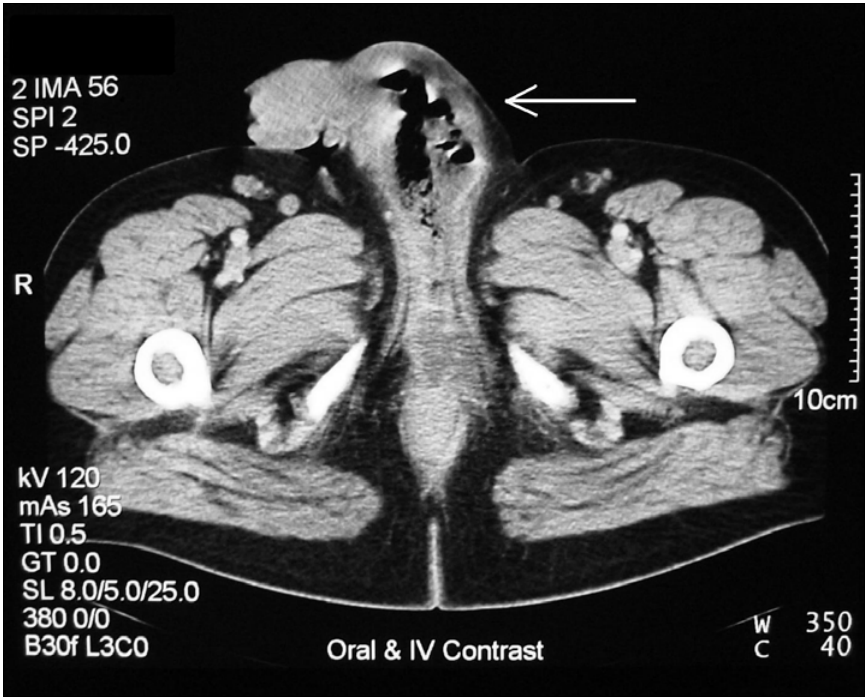
FIGURE 1. Demonstrating oedema of the scrotum and penis, with gas in the left corpus spongiosum extending into the